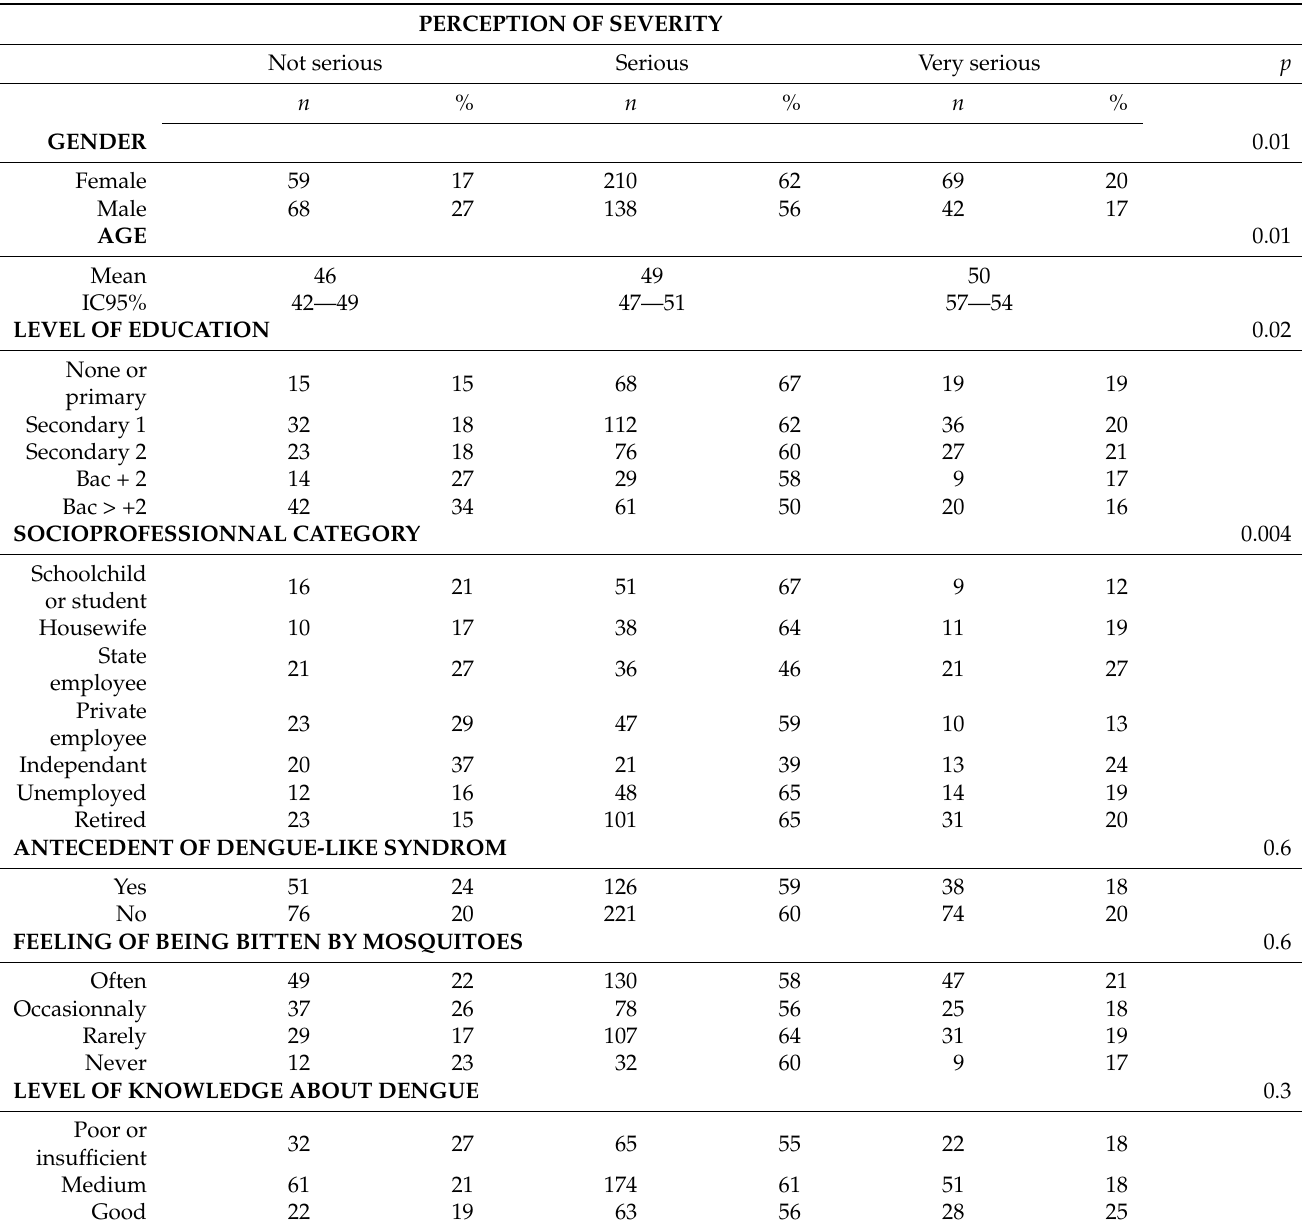
Table 2. Cross analysis between socio-demographic factors, previous experience of a dengue-like symptoms, level of knowledge about dengue, and perception of severity. PERCEPTION OF